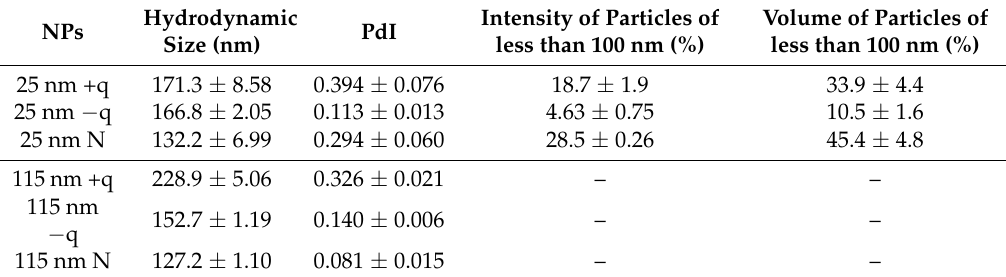
Table 1. Characterization of nanoparticles